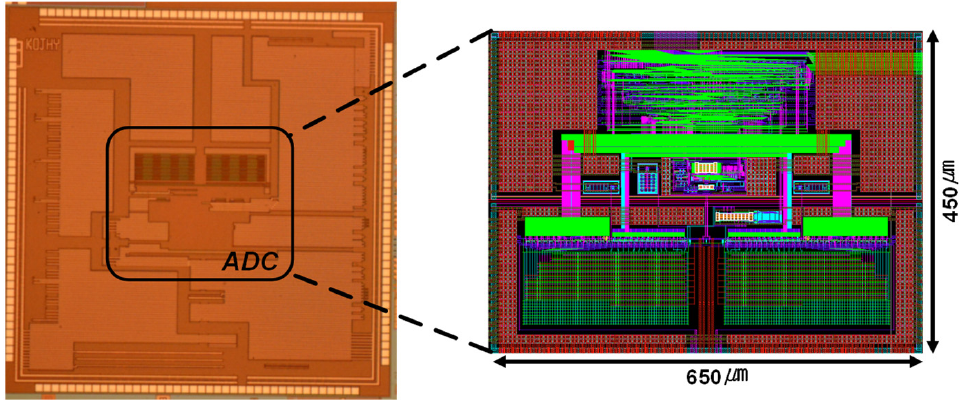
Figure 7. Chip photograph of implemented 11-bit SAR ADC.